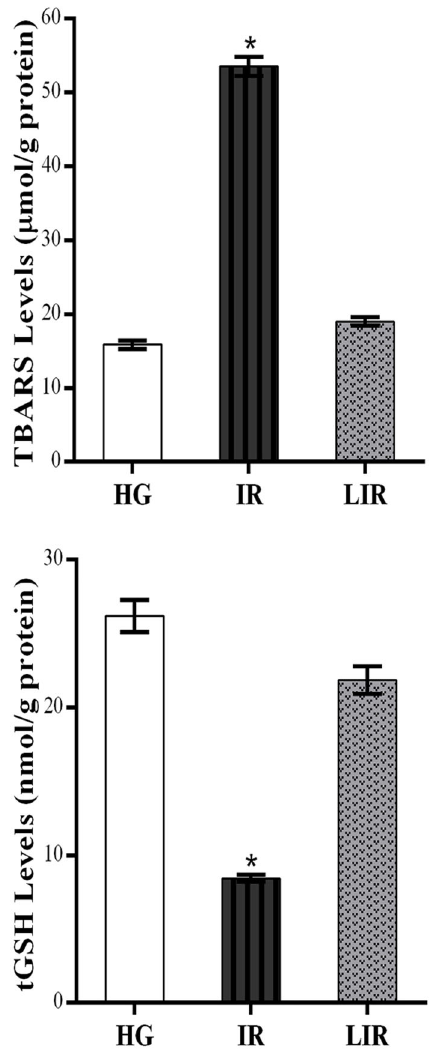
Figure 1. Thiobarbituric acid reactive substances (TBARS) and total glutathione (tGSH) levels of healthy control (HG), isoniazid + rifampicin (IR), and lycopene + isoniazid + rifampicin (LIR) groups in the kidney tissue. Data are reported as means ± SE. *P o 0.0001 compared to HG and LIR groups (n=6) (ANOVA followed by Fisher ’ s post hoc least signi fi cant